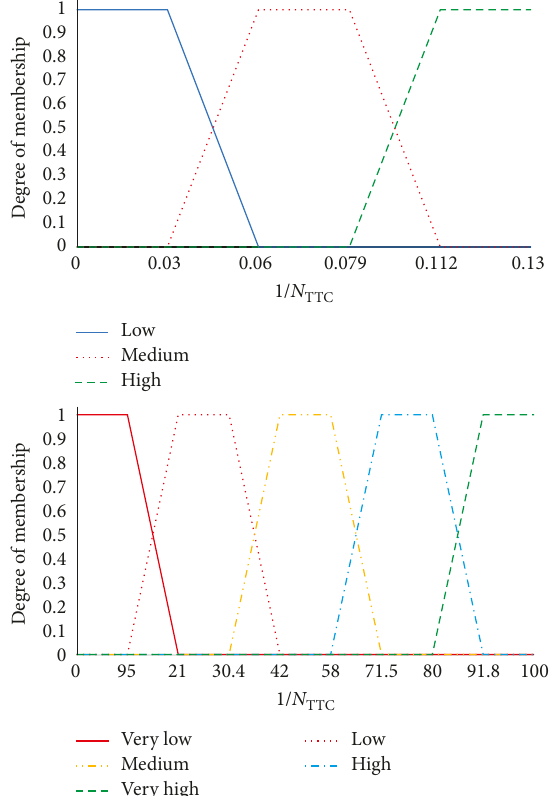
Figure 5: The membership functions for NCPI and N